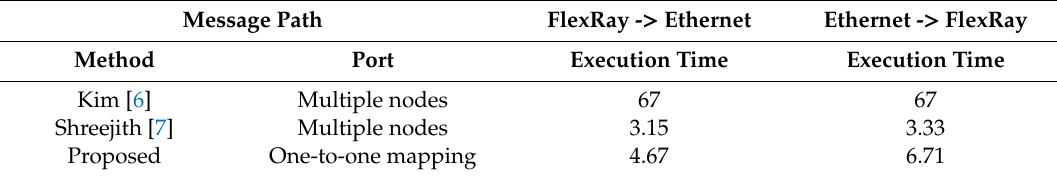
Table 8. Comparisons of FlexRay / Ethernet gateway execution time ( µ